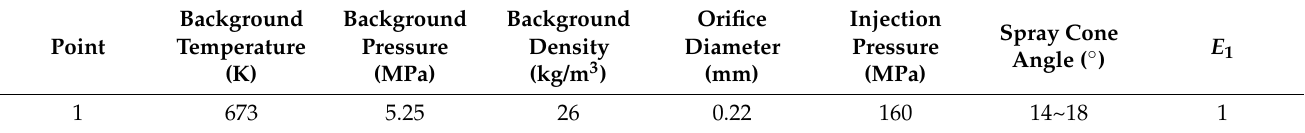
Table 8. Setting of experimental